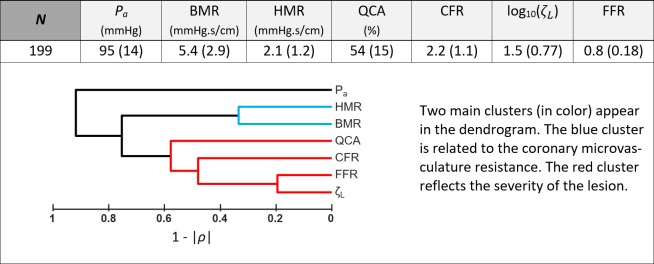
Hemodynamic parameters of the 1st dataset (n = 199). Pa.= aortic pressure; BMR = basal coronary microvascular resistance; HMR = hyperemic coronary microvascular resistance; QCA = diameter reduction (%) by quantitative coronary analysis; ζL = pressure loss coefficient; FFR = fractional flow reserve. The table reports median ± robust standard deviations. The dendrogram represents the average-link similarities returned by an agglomerative hierarchical clustering. Modulus of the Spearman’s rank correlation coefficient (ρ) was used as a distance metric; it reflects the proximity between two objects by measuring at what point they are similar. Reported values = median (interquartile range).